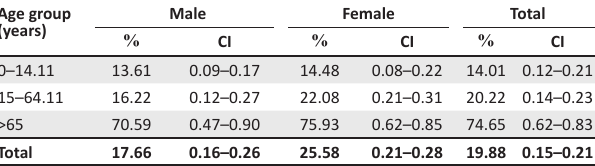
TABLE 2: Proportion of participants with hearing impairment ( % ) according to gender and World Health Organization age group categories ( n = 191). Age group (years)